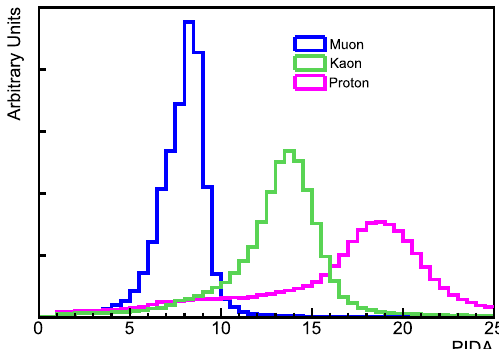
Fig. 30 Particle identification using PI DA for muons and kaons in simulated proton decay events, p → K + ν , and protons in simulated atmospheric neutrino background events. The curves are normalized by